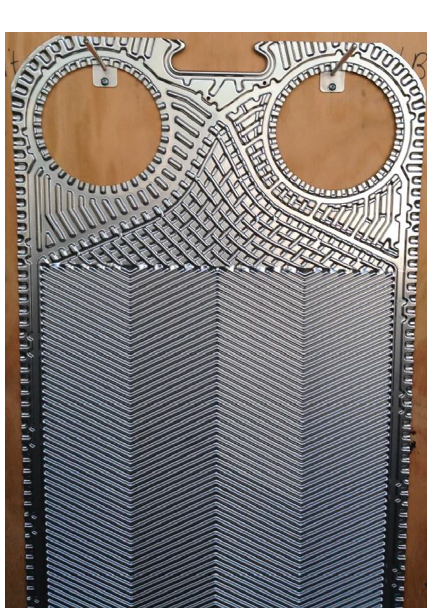
Figure 3: Geometrical parameters of a plate. (1) Corrugated field, (2) inlet distribution zone, and (3) outlet distribution